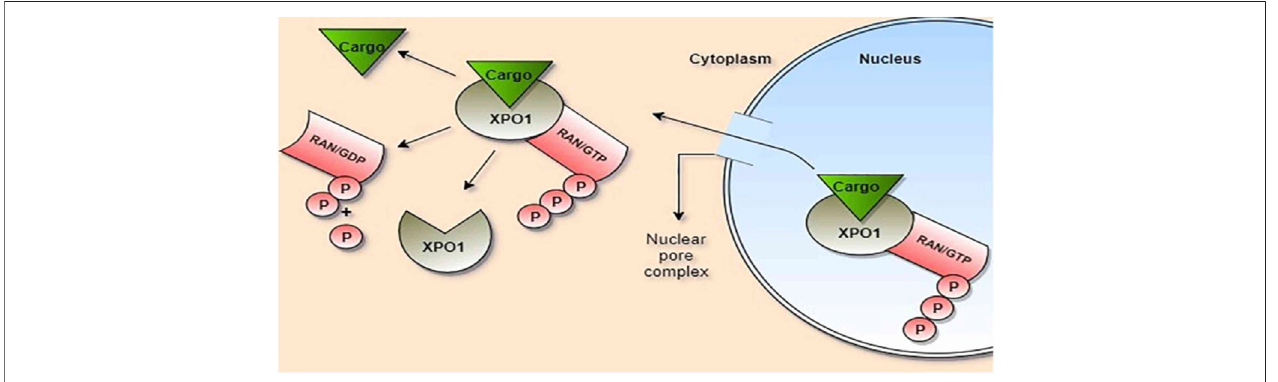
FIGURE 3 | Role of exportin-1 (XPO1) in the transport of cargo proteins: Cargo, ras-related nuclear protein (Ran), and guanosin triphosphate (GTP) bind to XPO1, forming a large complex which passes through the nuclear pore complex. Ran/GTP is hydrolyzed to Ran/GDP within the cytoplasm with the release of cargo and phosphate